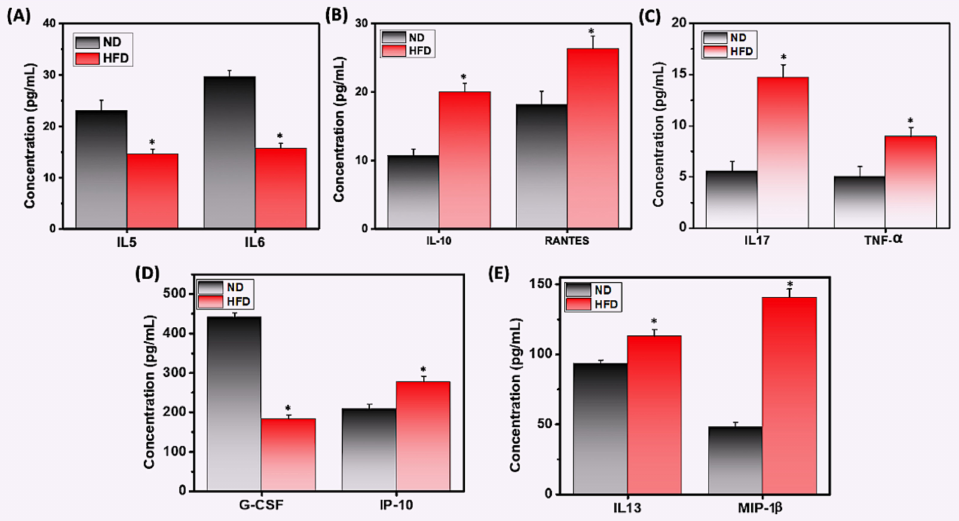
Figure 5. HFD differentially induces the expression of cytokines and chemokines in the serum of mice fed HFD or ND. Mice were fed HFD or ND for 12 weeks before sacrifice, and whole blood was collected from each group. Serum samples were prepared and analyzed by ELISA assay using antibodies specific for cytokines and chemokines G-CSF, IL-5, IL-6, IL-10, IL-13, IL-17, IP-10, MIP-1 β , RANTES, and TNF- α . ( A ) HFD suppressed systemic expression of IL-5 and IL-6 proteins, ( B , C , E ) increased levels of systemic IL-10, IL-13, IL-17, IP-10, MIP-1 β , RANTES, and TNF- α , and ( D ) suppressed levels of G-CSF, all relative to levels observed in mice fed ND. Data represent the levels of inflammatory cytokines and chemokines ± SEM from three independent